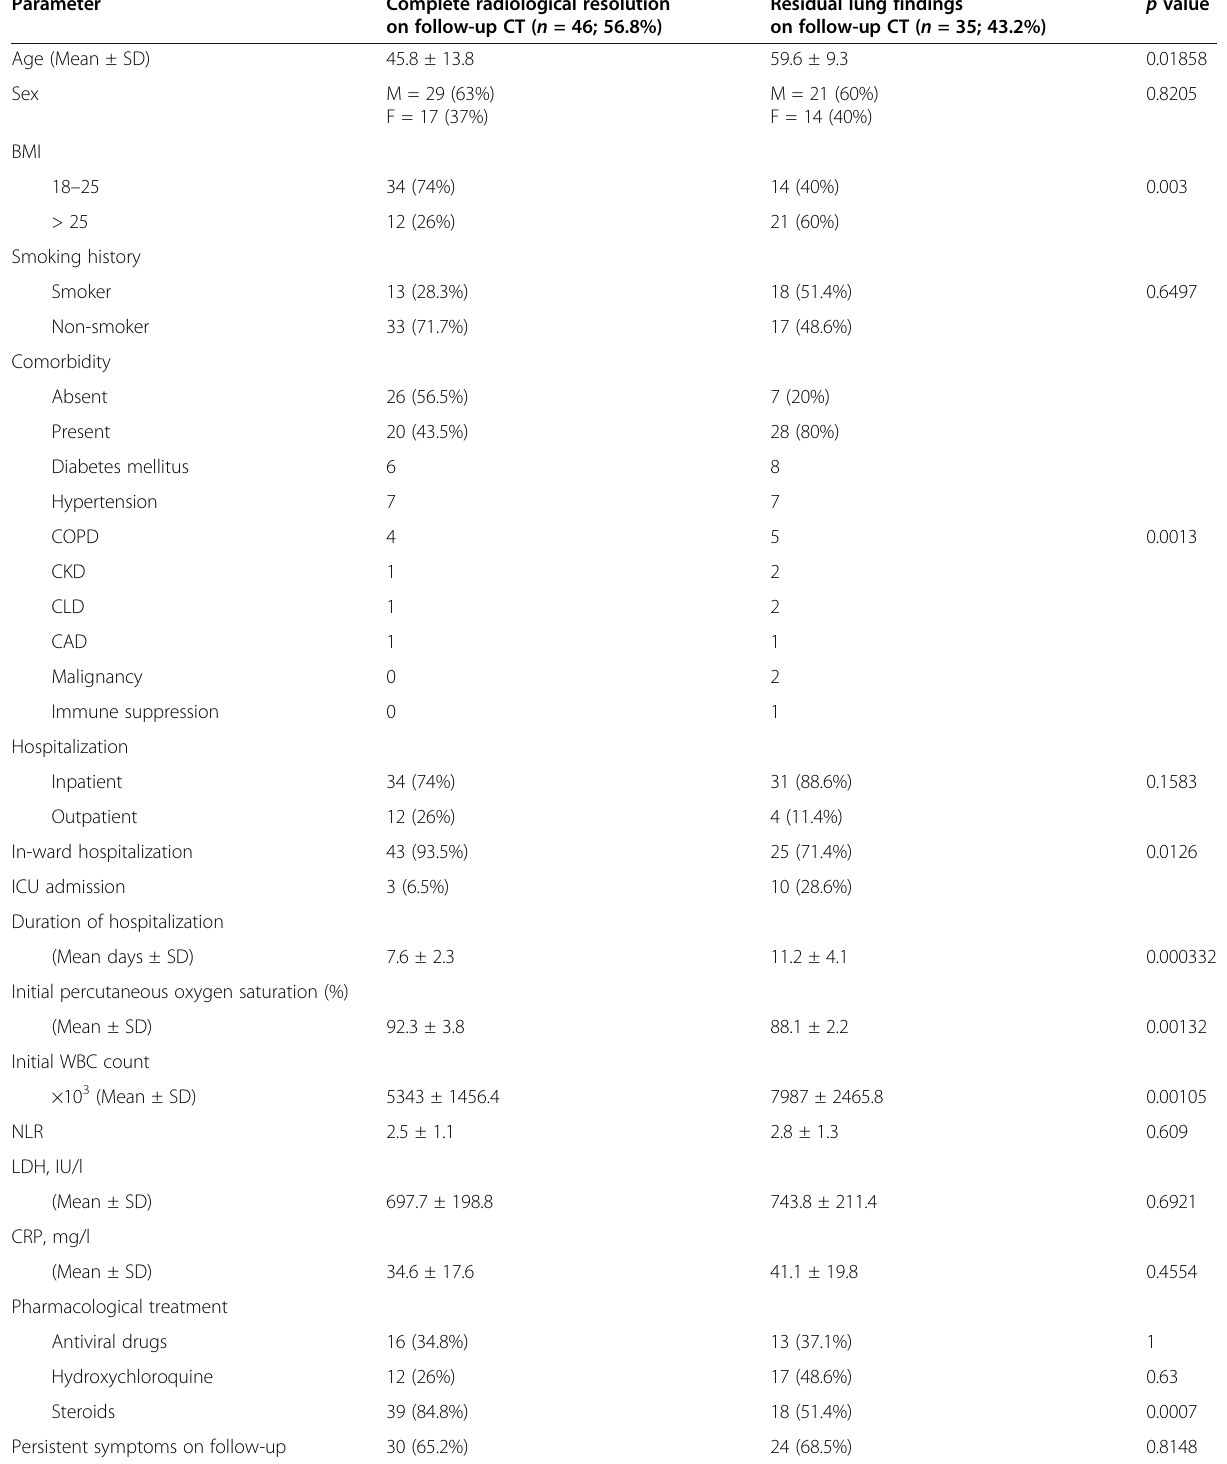
Table 1 Comparison of demographic, clinical, laboratory and therapeutic data between the two follow-up groups